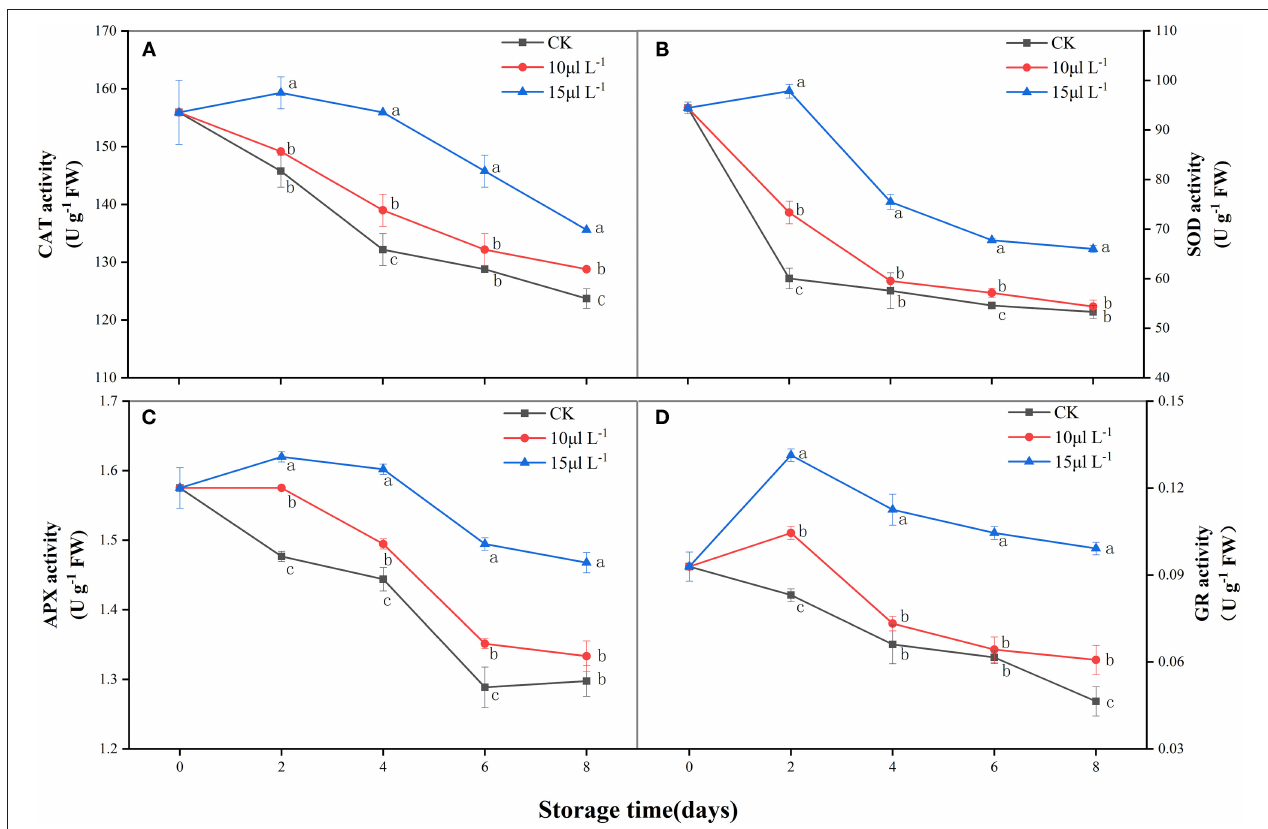
FIGURE 3 | Effects of H 2 S treatment on CAT (A) , SOD (B) , APX (C) , and GR (D) activities of fresh-cut Chinese water chestnuts during storage at 10 ◦ C for 8 days. Vertical bars represent the standard errors of the means. Different letters (at the same day) mean that they were significantly different (Duncan’s multiple range test, P < 0.05). CAT, catalase; SOD, superoxide dismutase; APX, ascorbate peroxidase; GR, glutathione